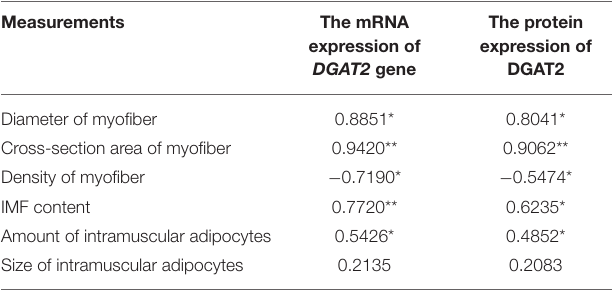
TABLE 2 | Correlation coefficients ( r ) between the mRNA/protein expression level of DGAT2 gene in breast muscle and muscle fiber diameter, cross-section area